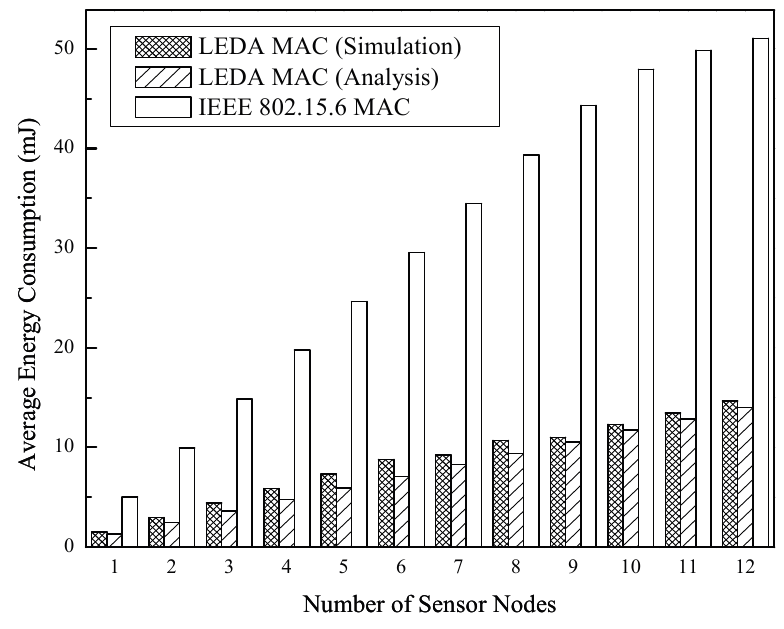
Figure 16. Total energy consumption at 50 kbps/node vs. number of sensor